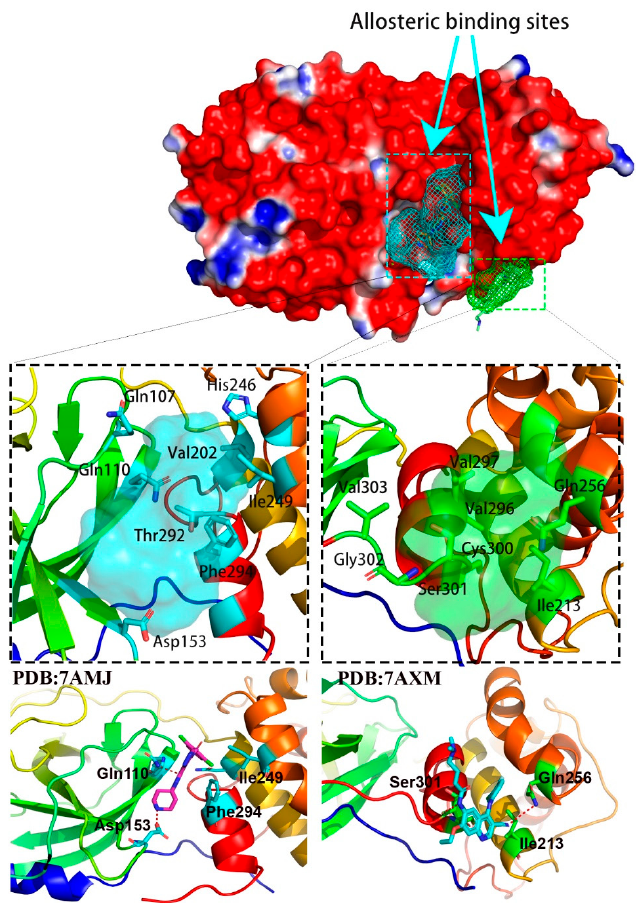
Figure 2. Two allosteric binding pockets in M pro structure of